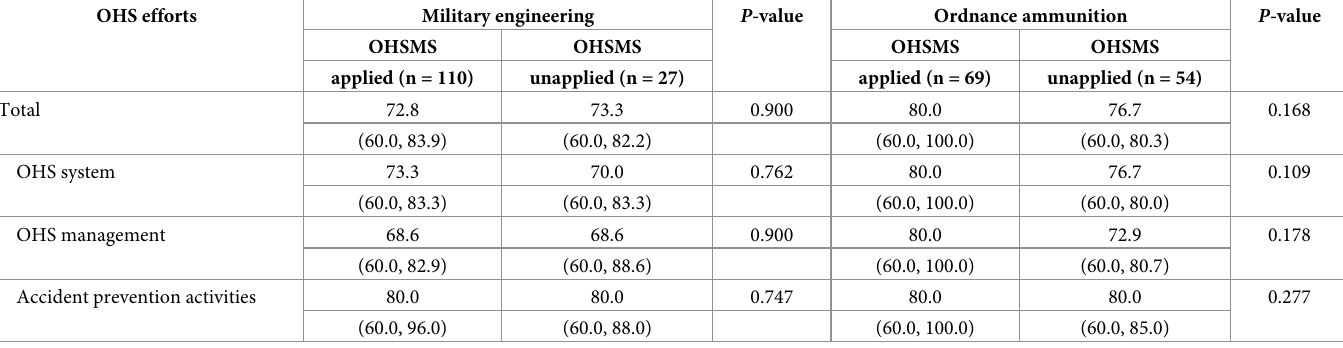
Data were presented as median (interquartile range).